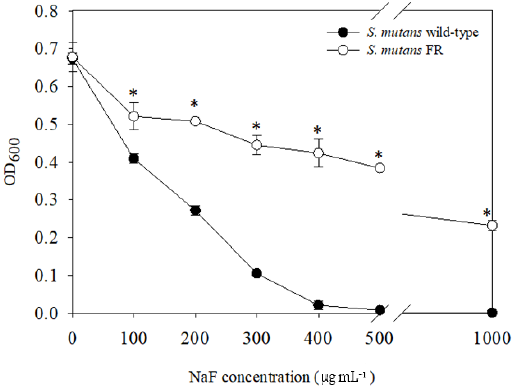
Figure 1. Growth of S. mutans wild-type and FR strains in the presence of fluoride. Cells were grown in BHI medium supplemented with increasing concentrations of NaF at 37 °C in a 5% CO 2 atmosphere for 24 h. The end-point growth was determined according to the OD 600 value using the Bioscreen C Lab System. The results represent the mean values of three biological repeats. * , differs from the wild-type strain at p < 0.05.